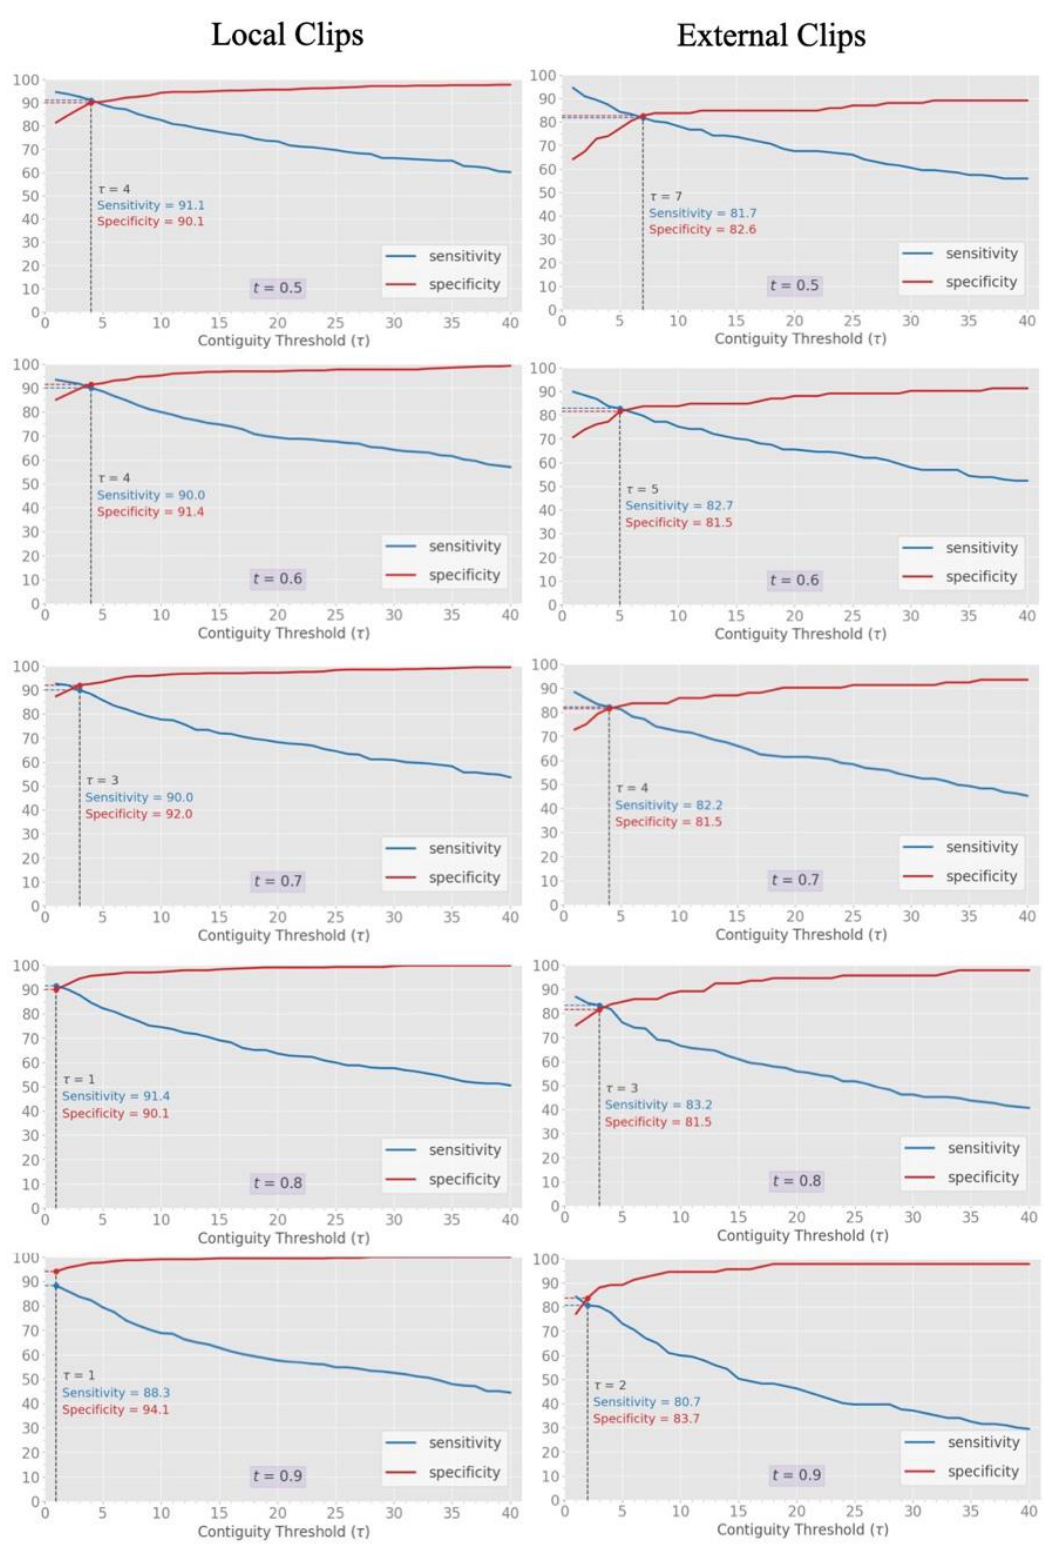
Figure 9. Influence of varying the contiguity threshold (T) and the classification threshold (t) across the internal and external clip-based data. While absolute diagnostic performance (intersection of sensitivity and specificity, dashed line) differed between the internal and external set, common trends in increasing both T and t were seen. Increases in T at lower levels of t are useful to increase performance at all levels for external data while this effect plateaus at a t of 0.8 for local